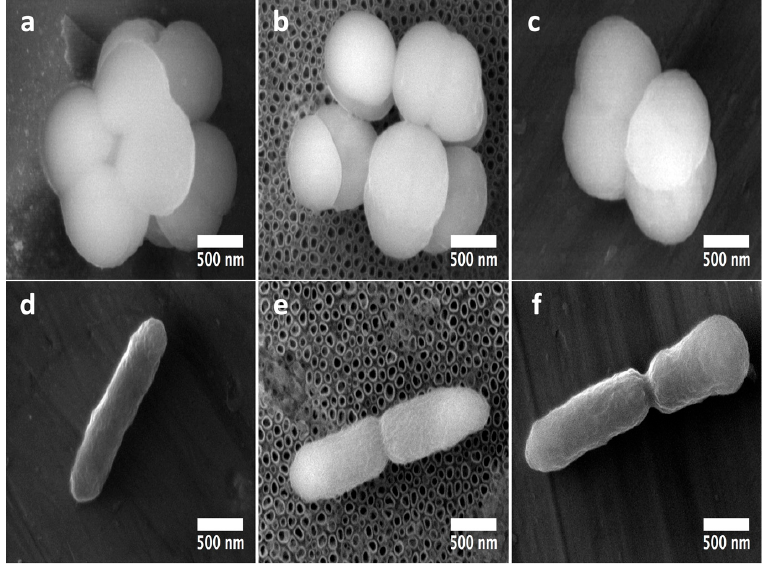
Figure 9. Nano-scale comparative bacteria-surface interactions among Gram-positive and Gram-negative bacteria on the experimental materials at 2 h: ( a ) S. epidermidis micrograph on the Flat-Ti6Al4V material; ( b ) 80 nm NTs clearly showing the poor adhesion patterns of S. epidermidis ; ( c ) S. epidermidis adhesion over the rough Ti6Al4V; ( d ) P. aeruginosa interaction over the flat Ti6Al4V; ( e ) bacilli contact on NTs; ( f ) P. aeruginosa onto the Rough material.